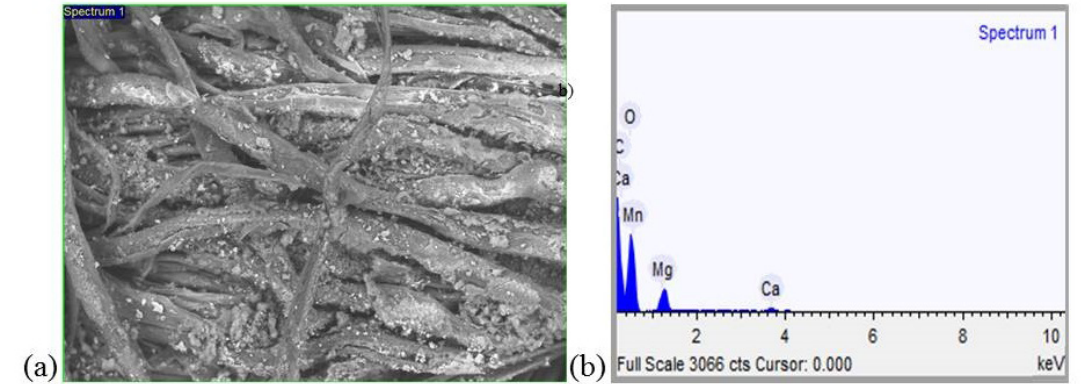
Figure 6. SEM image of the fabric bleached with seawater (a) and EDS spectrum (b). Table 6. Wettability test results. Time (seconds) for total absorption of the drop dye solution Samples Test